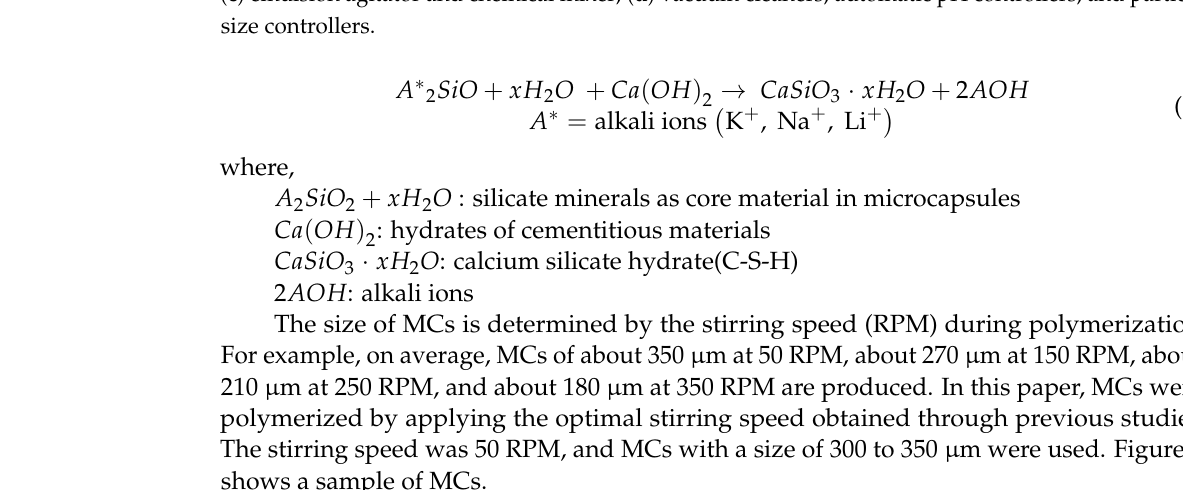
Figure 4. Manufacturing device of MCs: ( a ) drawing; ( b ) automatic manufacturing equipment; ( c ) emulsion agitator and chemical mixer; ( d ) vacuum cleaners, automatic pH controllers, and particle size